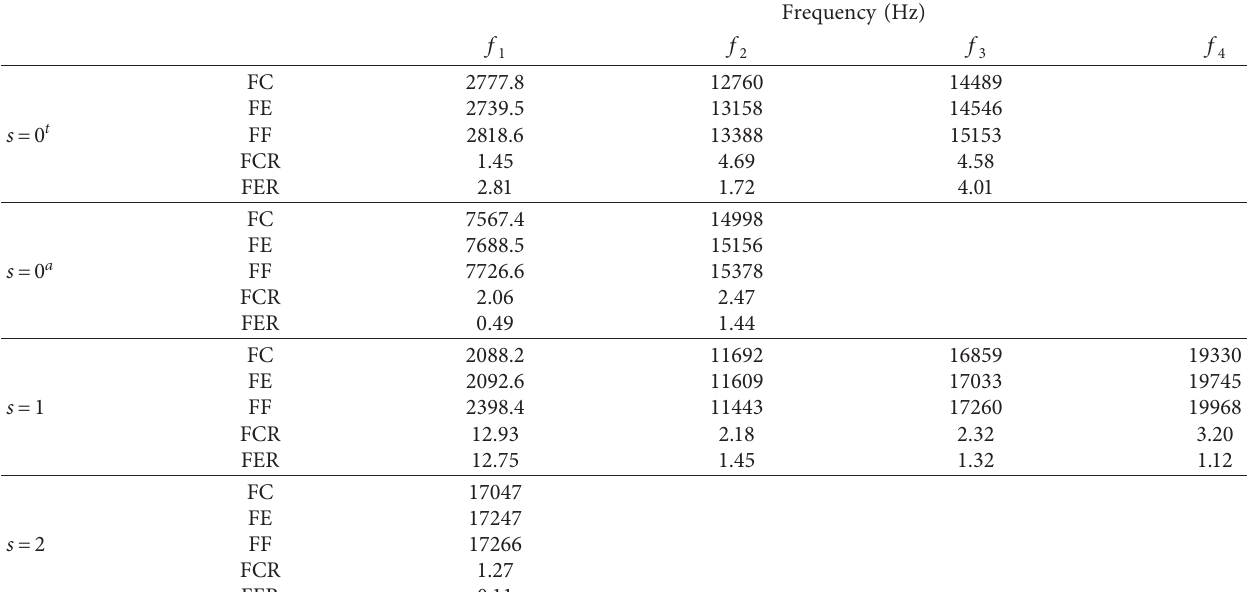
Table 5: Frequencies between 1 kHz and 20kHz of HGS3 obtained by the Chebyshev–Ritz method and the experiment compared with those obtained by the finite element